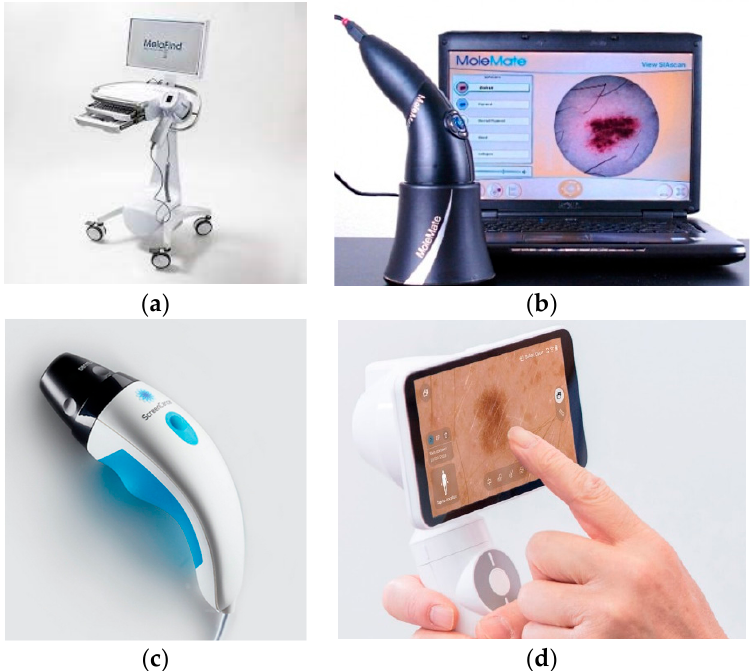
Figure 2. Multispectral commercial systems available for dermatology: ( a ) MelaFind [39], ( b ) SiaS-